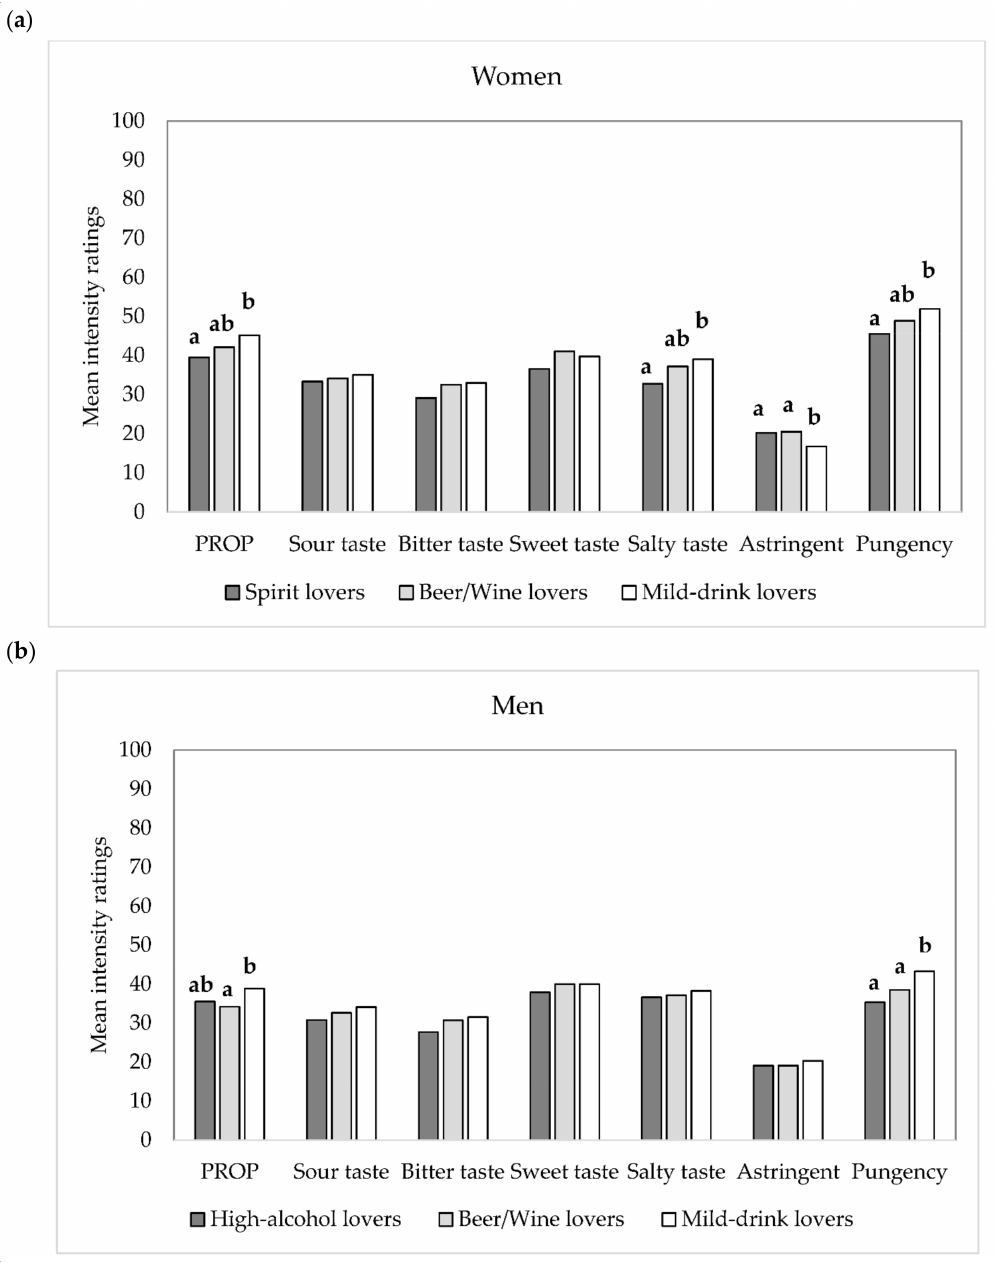
Figure 4. Mean intensity ratings for oral stimuli in the three consumers segments (spirit lovers, beer / wine lovers, and mild-drink lovers) of women, n = 1353 ( a ) and men, n = 978 ( b ). Di ff erent letters indicate significant di ff erences according to Bonferroni post-hoc